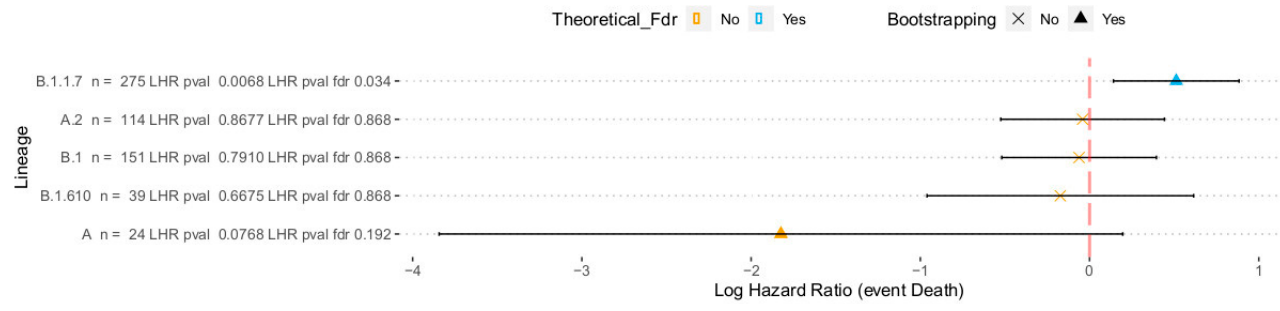
Figure 2. Log hazard ratios estimated for the five variants eligible for the causal analysis using the two approaches described in the text (the closed form estimator and the bootstrap). For each analysis, an estimate of the LHR along with a 95% confidence interval and a p -value (FDR-adjusted) of significance is provided. Viruses 2022 , 14 , x FOR PEER REVIEW